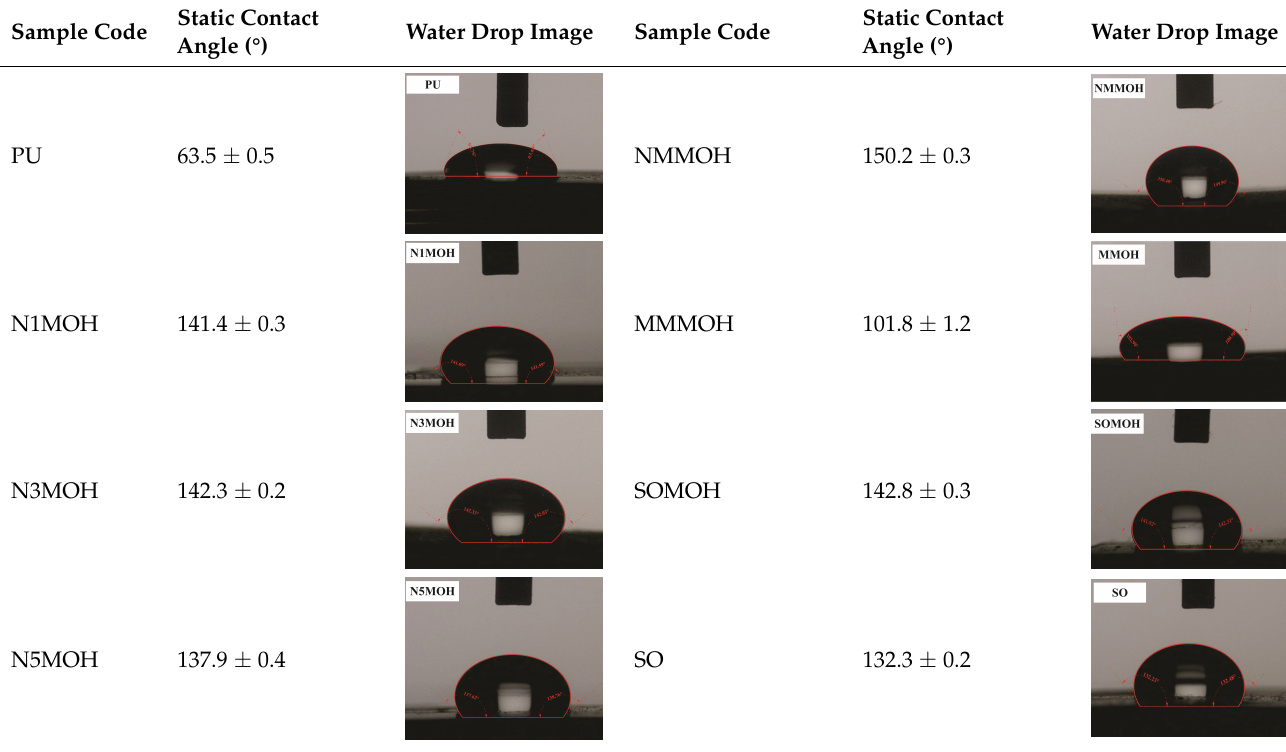
Table 3. Static contact angle of the PU composites. The presence of different fillers including nMOH, mMOH, and SO had a direct effect on how the drop was placed on the